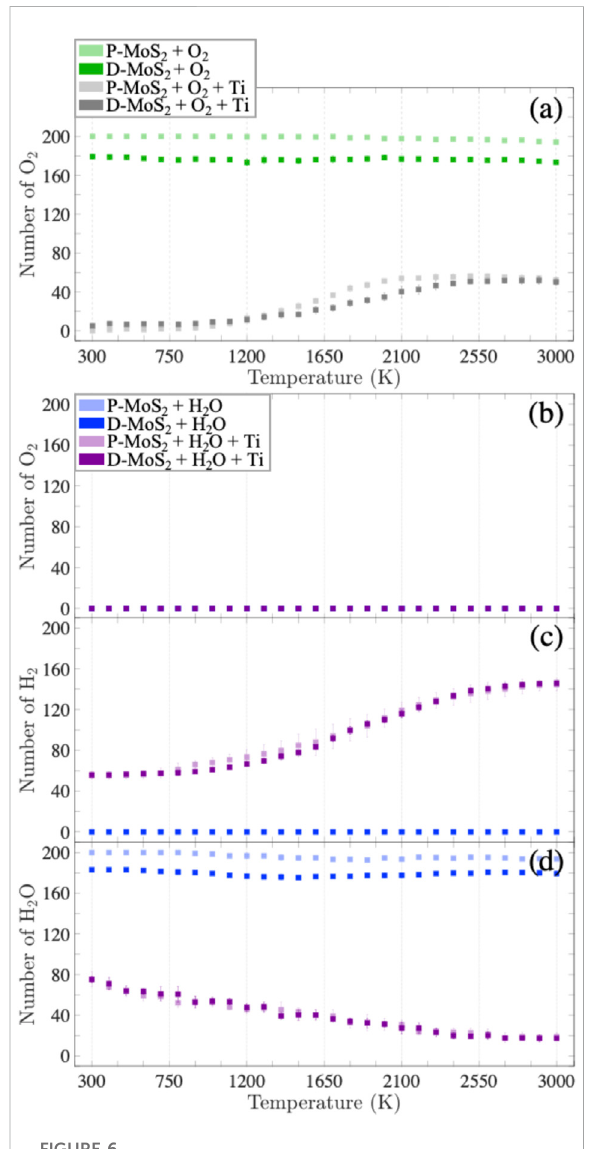
FIGURE 6 Evolution of the number of (A) O 2 gas molecules for the systems with O 2 at elevated temperatures; evolution of the numbers of (B) O 2 gas molecules, (C) H 2 gas molecules, and (D) H 2 O gas molecules for the systems with H 2 O at elevated temperatures. The light green, dark green, light gray, dark gray, light blue, dark blue, light purple, and dark purple squares represent the mean values of gas molecule numbers for the cases of P-MoS 2 + O 2 , D-MoS 2 + O 2 , P-MoS 2 + O 2 + Ti, D-MoS 2 + O 2 + Ti, P-MoS 2 + H 2 O, D-MoS 2 + H 2 O, P-MoS 2 + H 2 O+ Ti, D-MoS 2 + H 2 O+ Ti, respectively. The error bars indicate the standard deviations. The mean values and the standard deviations are derived from six con fi gurations for each system,